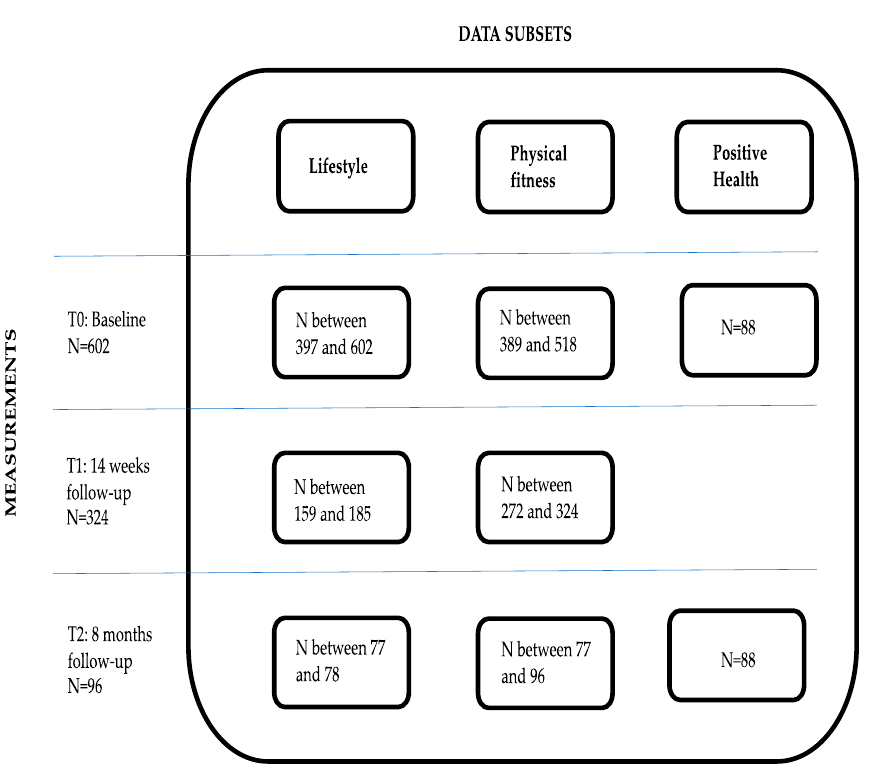
Figure 1. Overview of the participants on healthyLIFE.